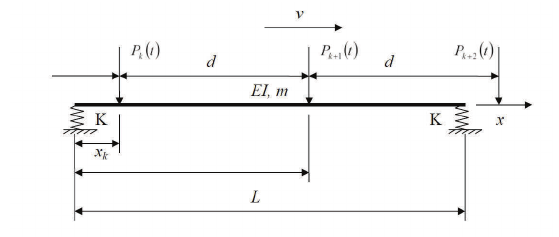
Figure 1. Elastically supported beam subjected with uni- form moving